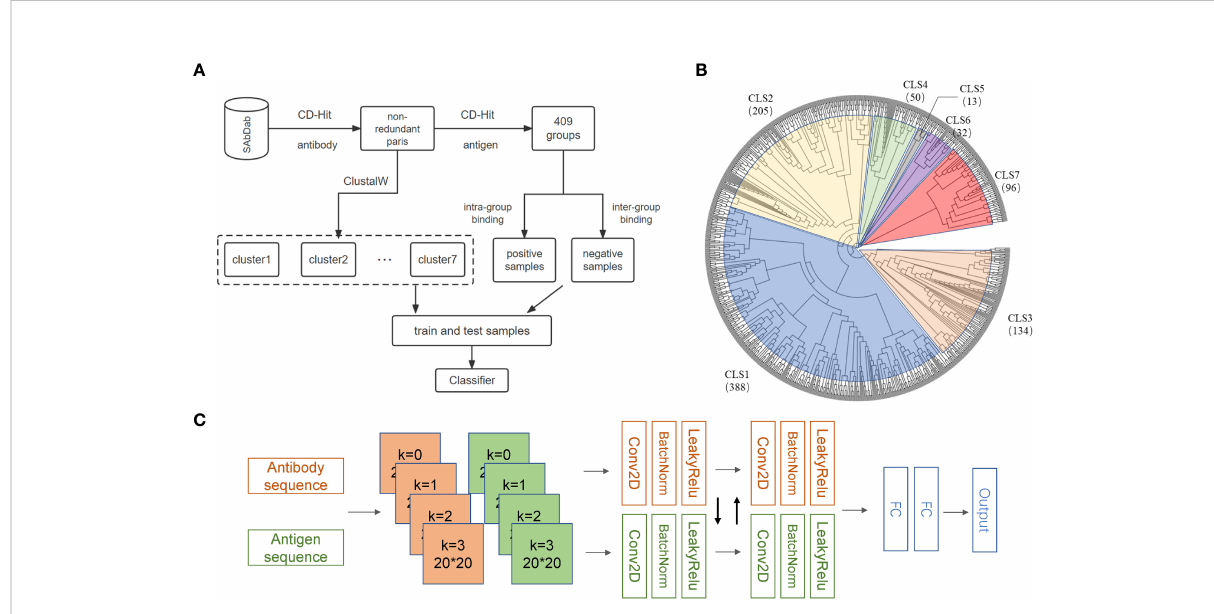
FIGURE 1 Overview of AbAgIntPre. (A) Flowchart of the generic prediction model of AbAgIntPre. (B) Clustering tree of 918 antigens in 408 subgroups. (C) The Siamese-like CNN framework of